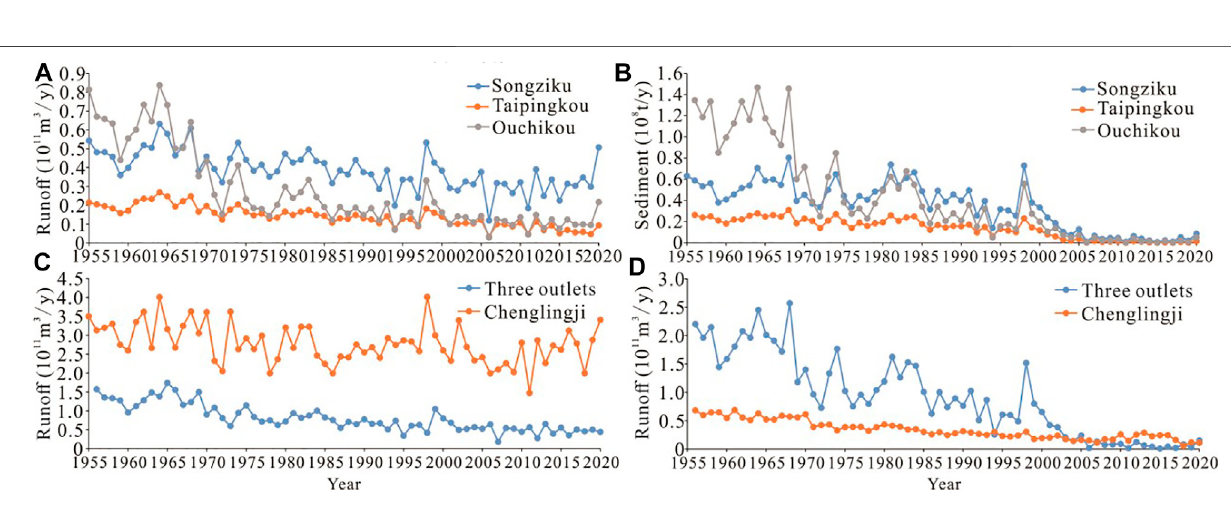
Frontiers in Earth Science |